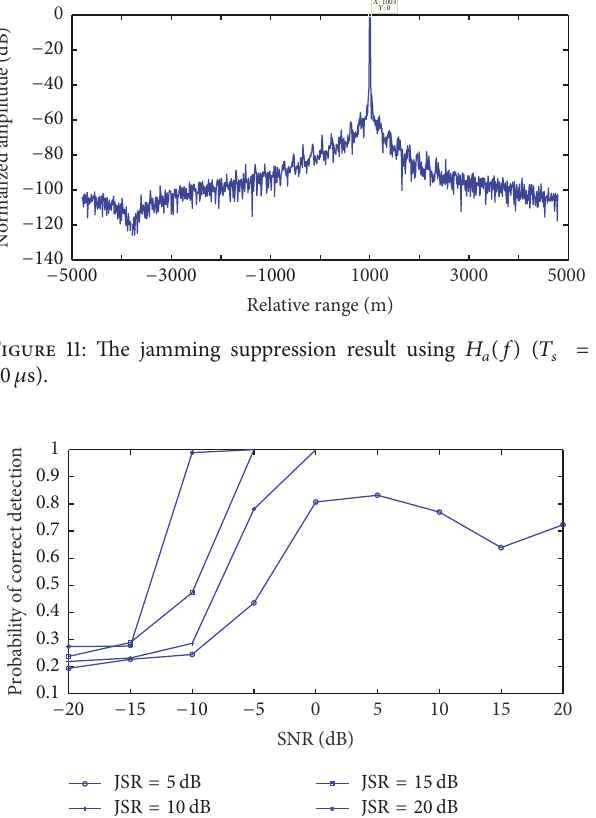
Figure 12: Detection probability of the true target with different SNR under different